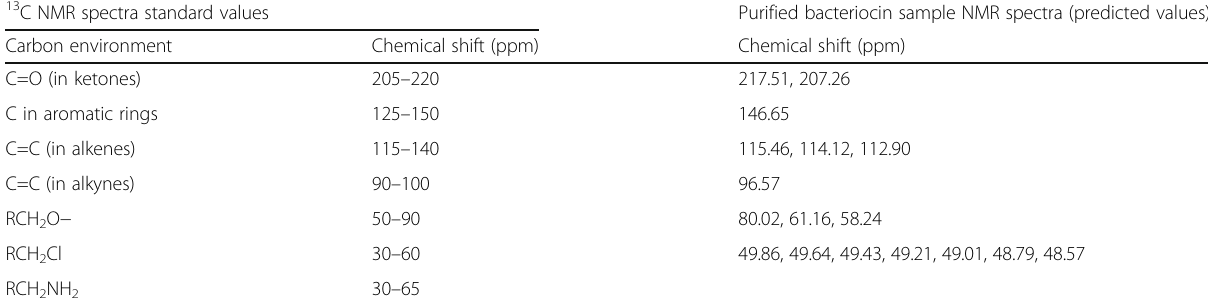
Table 3 13 C NMR spectral data. Various groups of carbon being detected in purified bacteriocin ABC transporter isolated from E. casseliflavus MI001